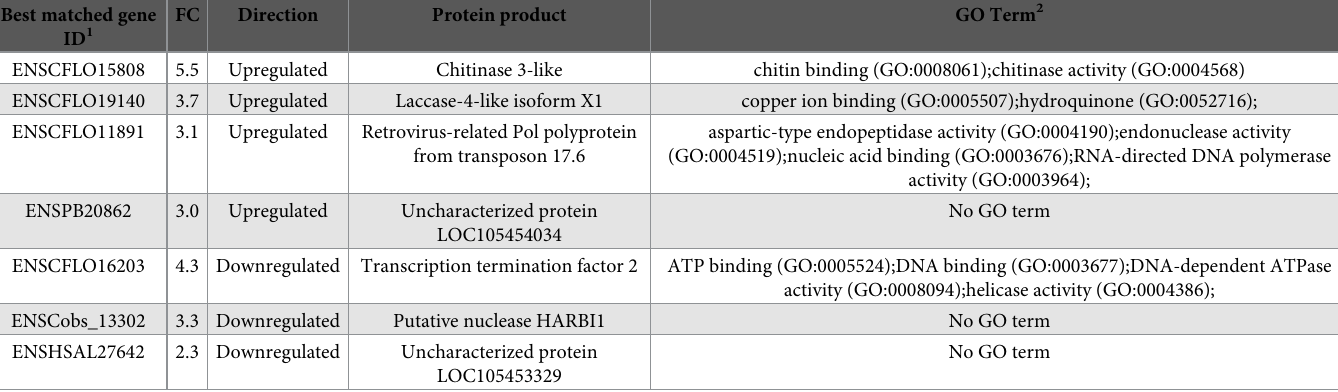
Gene ontology and functional annotation All transcripts were assigned GO or KEGG numbers based on sequence homology. For the heat induced transcripts, 325 (51%) of the 636 DETs could be assigned GO numbers. GO func- tional classification of these DETs revealed that 199 (47%) of the 426 upregulated DETs could be categorized into 48 functional groups (Fig 2). Across all the GO domains, we found a high percentage of genes in cell, organelle, cell part, binding, cellular process, biological regulation, and metabolic process. The functional classification of the downregulated DETs resulted in 124 (59%) of the 210 DETs categorized into 46 functional groups. Across all the GO domains, Table 2. Proteins that have been differentially expressed after cold stress in P . imparis